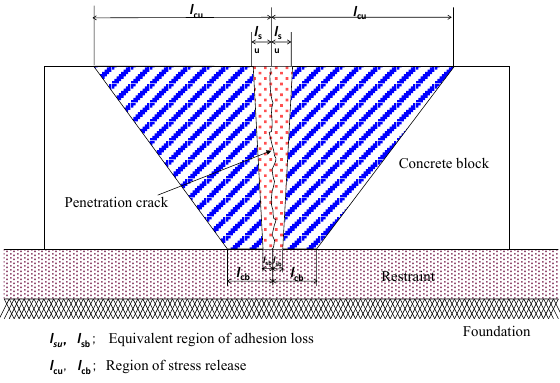
Figure 4. Outline of the analysis model in the CP crack width